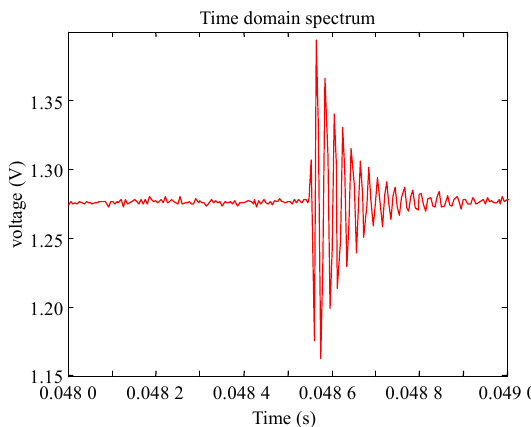
Fig. 6 Typical micro plasma shock wave acoustic emission signal by femtosecond laser ablation of aluminium copper alloy